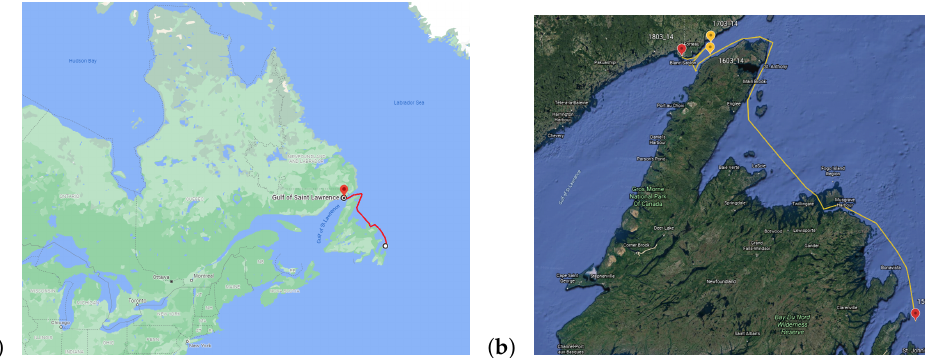
Figure 9. Route on 15–18 March 2020: larger view ( a ) and zoomed view ( b ) (via Google Earth ®